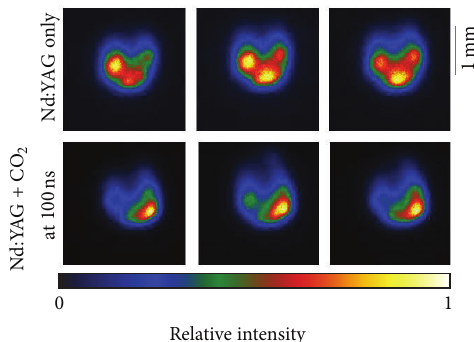
Figure 14: Effect of reheating CO 2 pulse on spectrally integrated plasma images. The reheating laser impinges on the plasma from the lower right in this camera angle. The target is at the top of each image. TheCO 2 pulsearrives100 nsafter theNd:YAG ablation pulse, with the ICCD gate set to 180 ns after the Nd:YAG pulse.